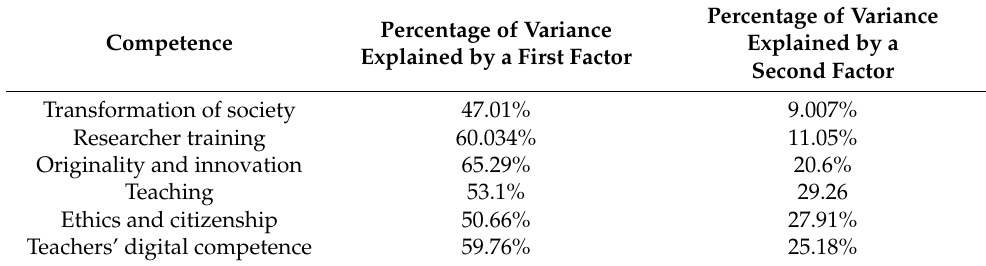
Table 6. Percentages of Variance Explained by First and Second Factors and Factor